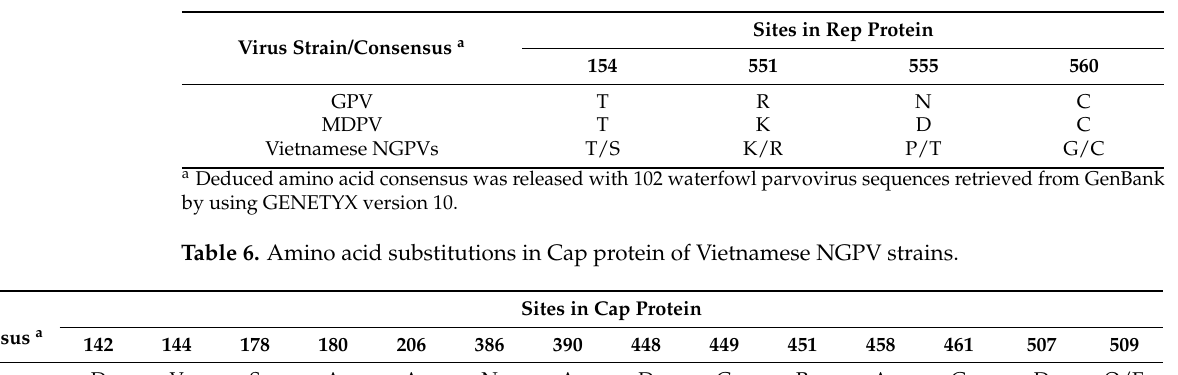
Table 5. Amino acid substitutions in Rep protein of Vietnamese NGPV strains.